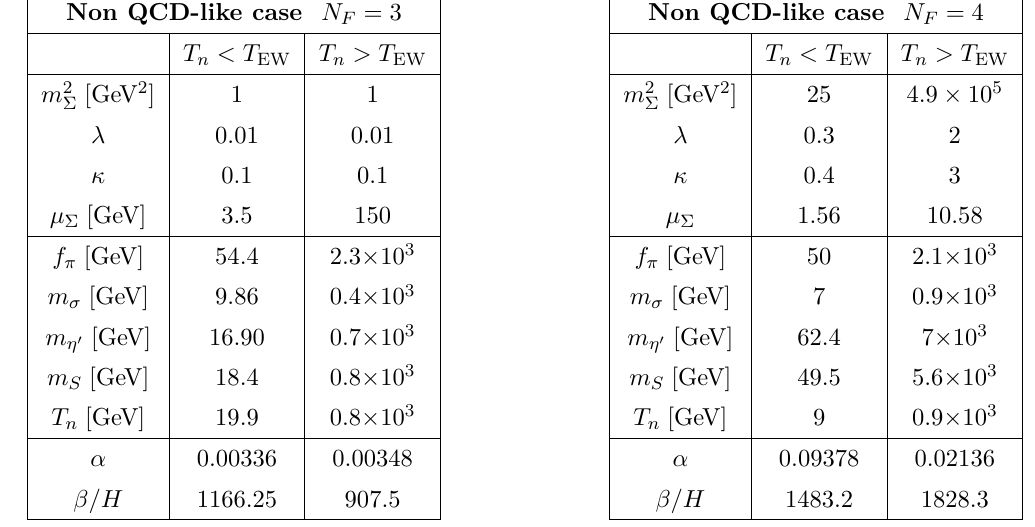
If this happens in the chiral limit, an immediate consequence is that typically m